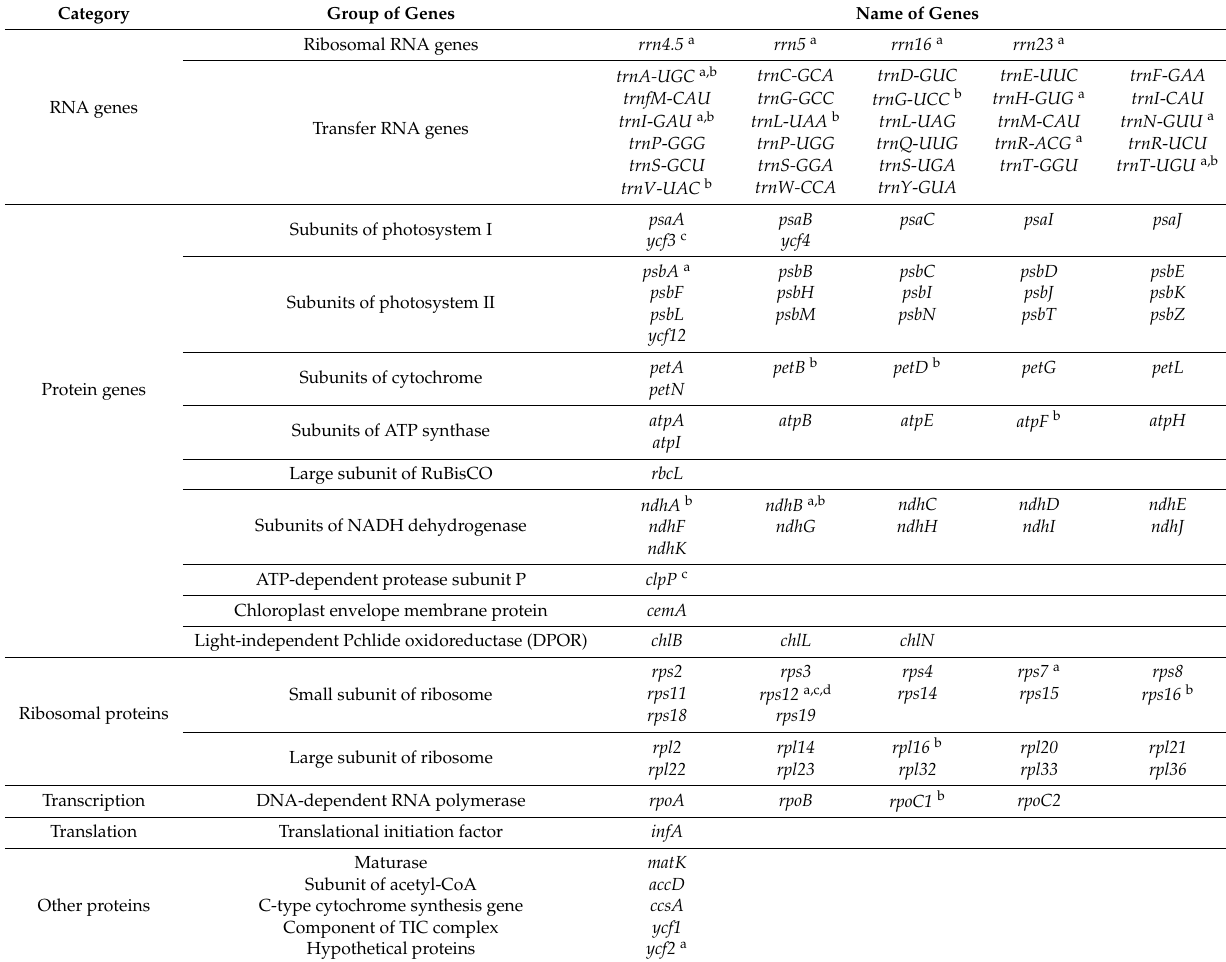
Table 1. List of genes present in the chloroplast (cp) genome of Cyrtomium